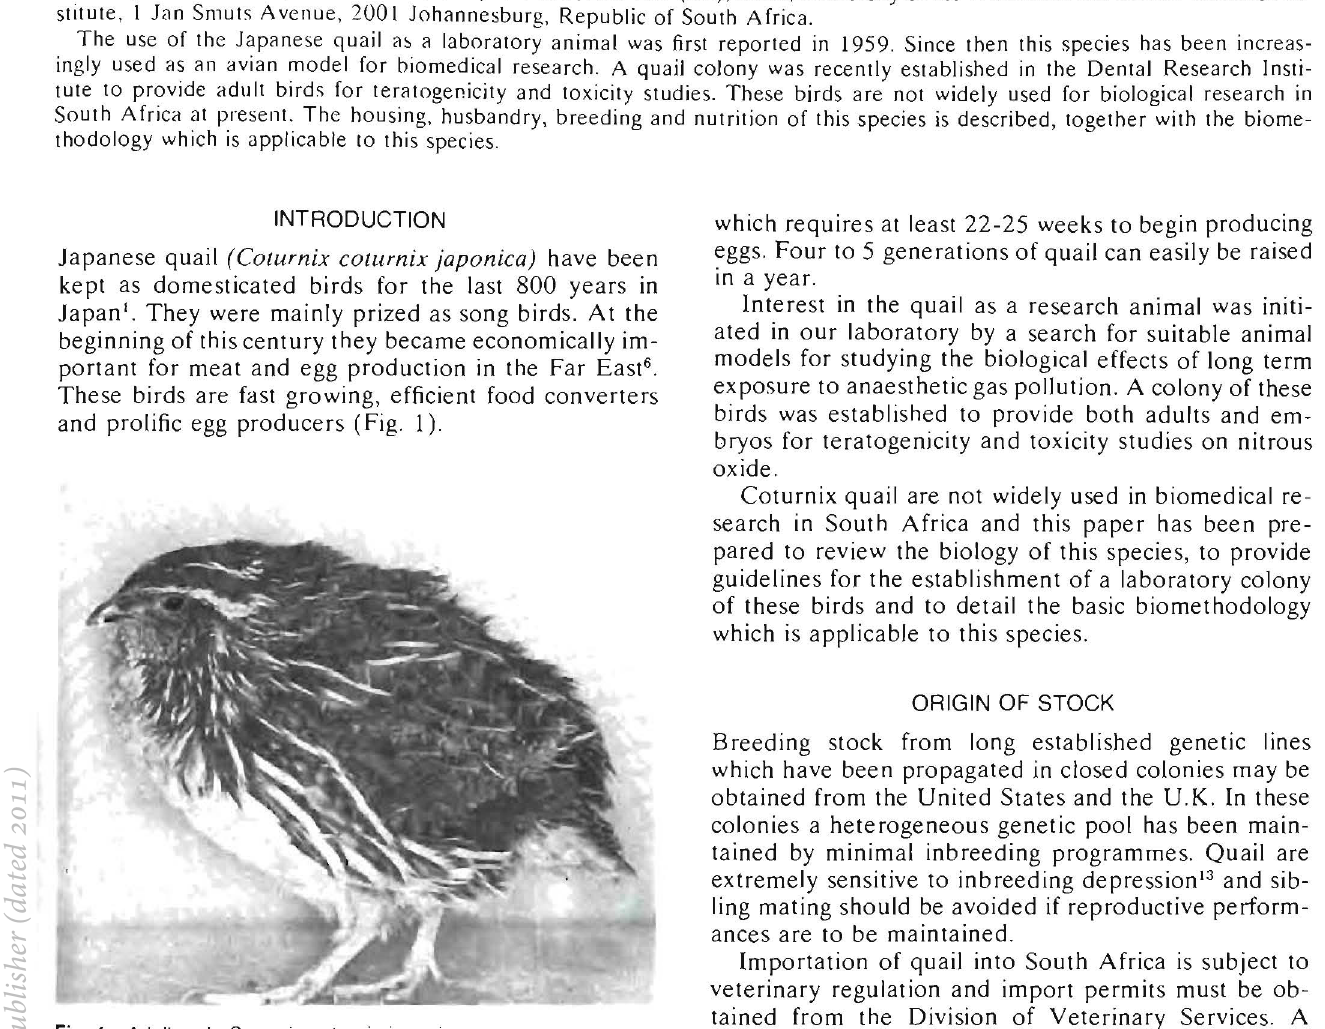
Fig. 1 Adult male Corurnix coturnix